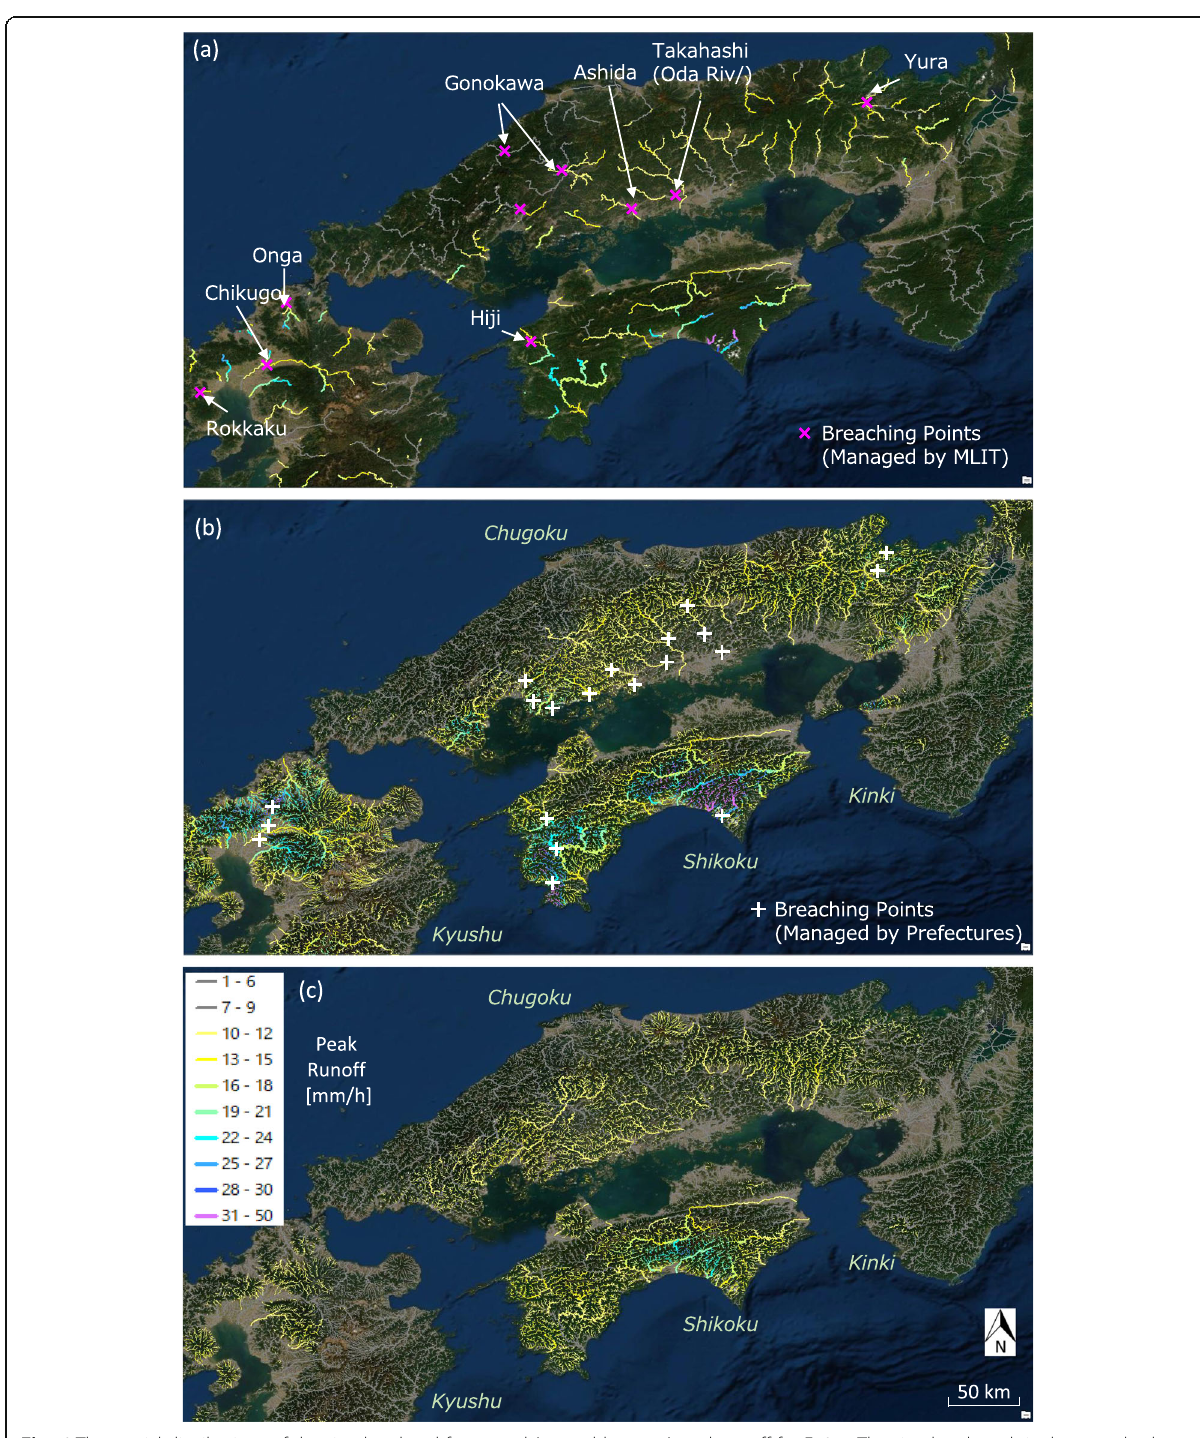
Fig. 6 The spatial distributions of the simulated and forecasted (ensemble mean) peak runoff for F18. a The simulated result is shown only along the main rivers (upstream contributing area: 100 – 5500 km 2 ). b The simulated result for all rivers (upstream contributing area: 1 – 5500 km2). c The forecasted result for all